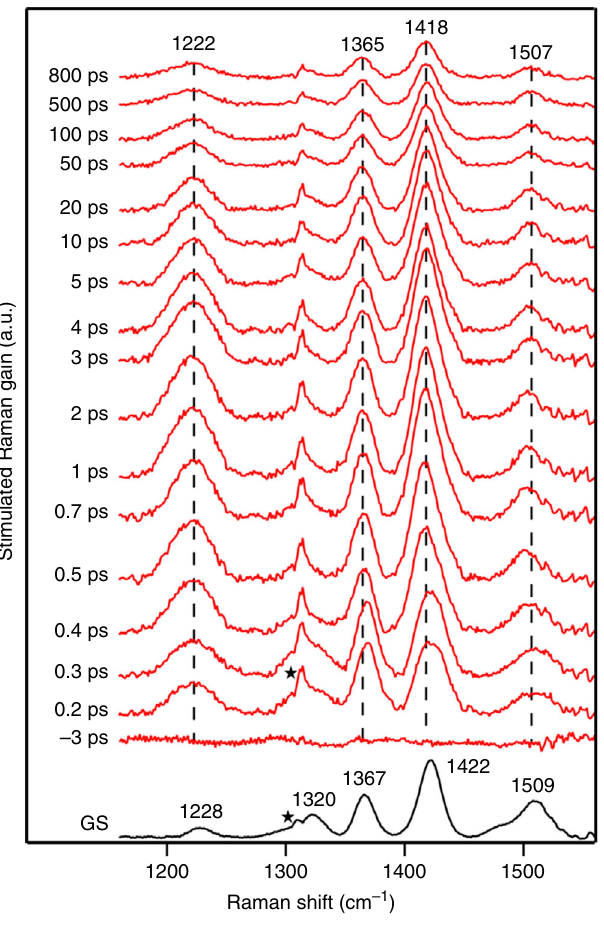
Fig. 4 Femtosecond stimulated Raman spectra of TDPP-BBT in chlorobenzene. Excited state Raman spectra at different pump-probe delay times has been shown. The ground state and excited state Raman signals are represented by black and red traces respectively. Asterisk mark represents instrumental